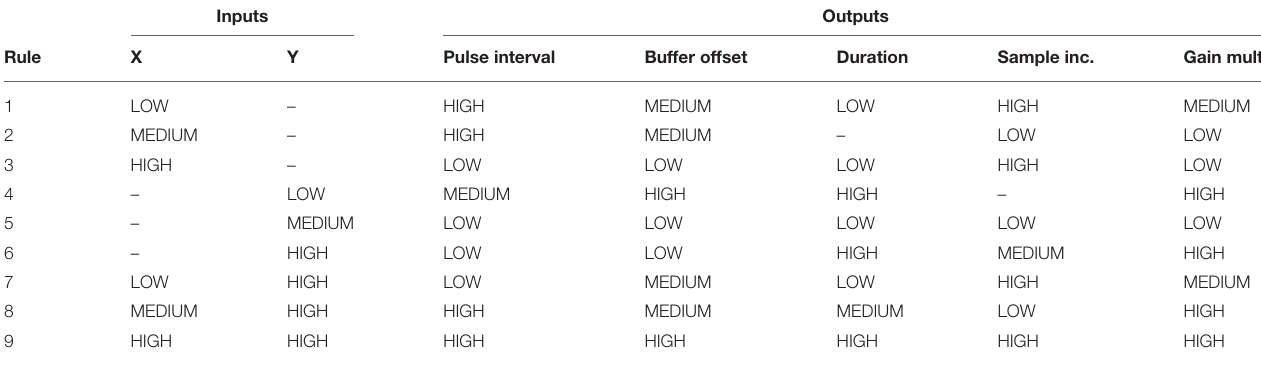
TABLE 6 | Fuzzy rules used in the granular synthesis